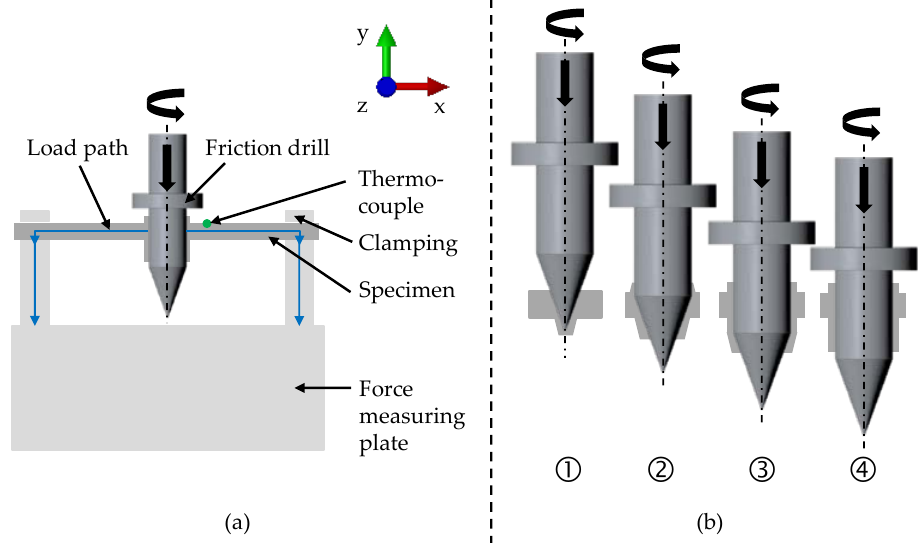
Figure 3. Schematic illustration of the experimental setup for friction drilling with force measurement ( a ) and states of the friction drilling ( b ): entering ( 1 ) and breakthrough ( 2 ) of the conical part of the friction drill; and entering ( 3 ) and breakthrough ( 4 ) of the cylindrical part.